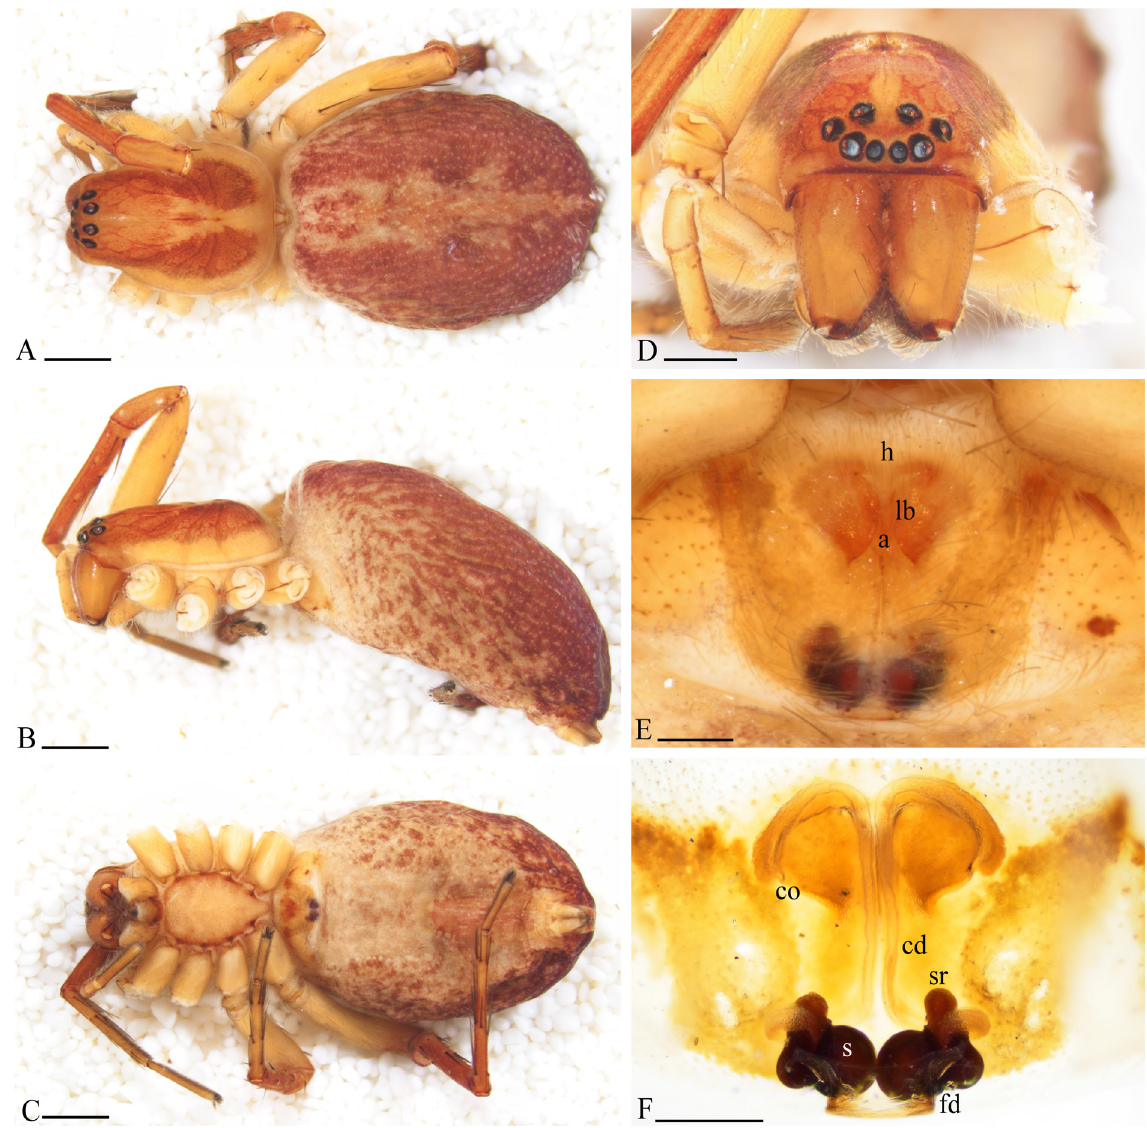
Fig. 42. Anyphaena salgueiroi sp. nov., holotype, ♀ (CNAN-T01537). A . Dorsal habitus. B . Lateral habitus. C . Ventral habitus. D . Prosoma, anterior view. E . Epigynum, ventral view. F . Epigynum, dorsal view. Scale bars: A–C = 1.0 mm; D = 0.5 mm; E–F = 0.2